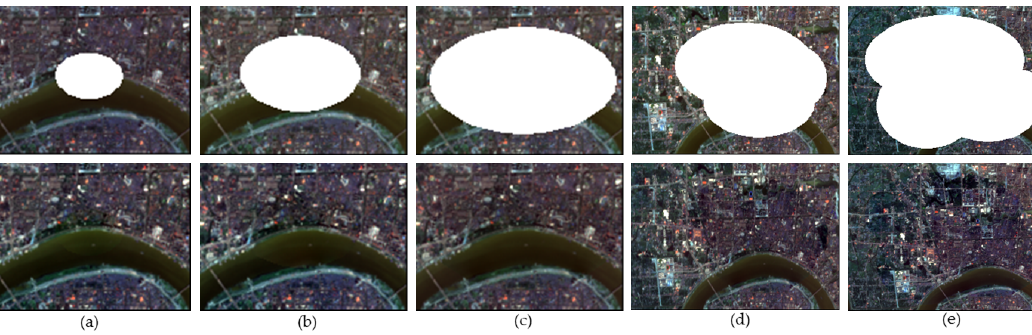
Figure 14. ( a )–( e ) Detailed regions clipped from Figure 13a–e.